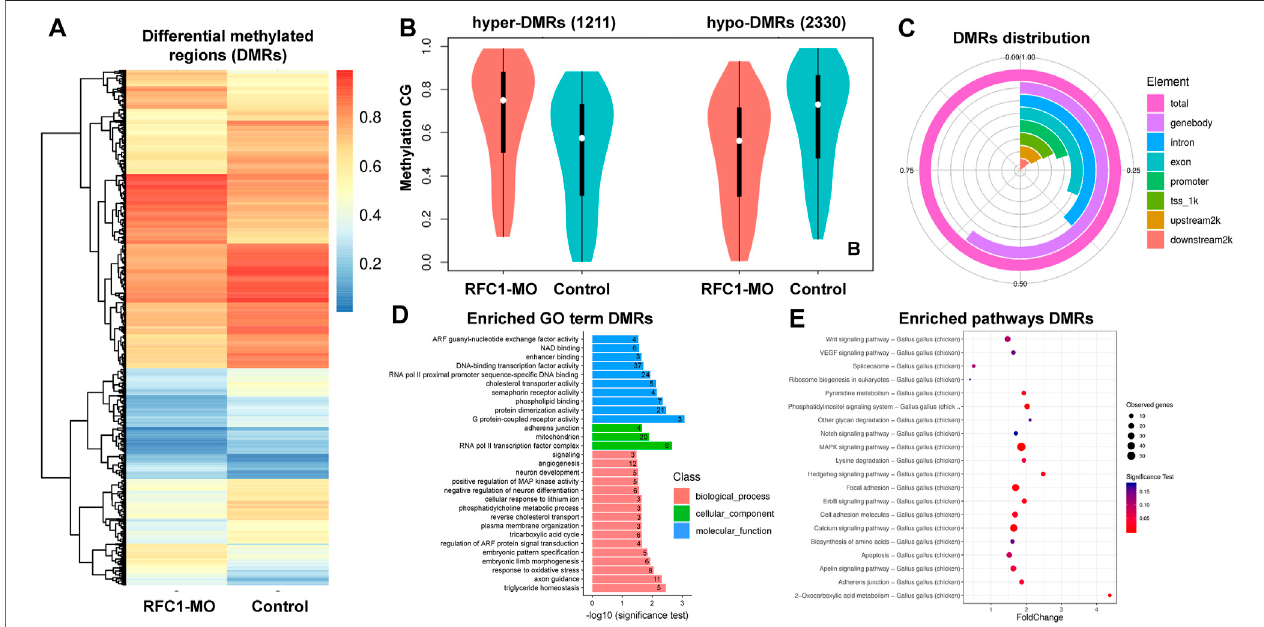
FIGURE4| Identi fi cationofdifferentiallymethylatedregions(DMRs)onfolatecarrierde fi cientembryos. (A) HeatmapofDMRsshowingsigni fi cantdifferencesinCG methylation between the folate de fi cient (RFC1-MO) and control (Control) embryos. Each raw in the heat map correspond to data point from single region, whereas column correspond to treatments. The branching dendogram correspond to the relationship among data point as determined by clustering using 3,541 DMRs. Hyper- and hypomethylated regions are shown on a continuum from red to blue, respectively. See also Supplementary Table S1 . (B) Violin boxplot comparing hyper- (1,121) and hypo- (2,330) DMRs between the control and RFC1-MO embryos. (C) Genomic distribution of the DMRs. From the 3,541 DMRs, 2,145 were at the gene body, 590 upstream2k, 493 downstream2k, 1,348 in introns, and 712 in promoters. (D) Bar plot showing enriched Gene Ontology (GO) terms from genes associated with the DMRs. Numbers inside each bar indicates the total of GO-related genes. The horizontal axis indicates the signi fi cance of the test (adjP). See also Supplementary TableS2 . (E) Scatterplot showing enriched KEGG pathways from genesassociated withthe DMRs. The vertical axis representsthepathway and the horizontal axis represent the fold change. The size of the dots indicates the number of affected genes in the pathway and the color corresponds to a different p -value range.Seealso SupplementaryTableS3 .DMRsanalysiswasperformedbyusingmetilenesoftwareusingadoublestatisticaltest(MWU-testand2DKS-test)followed by multiple test correction (adj. p -value). GO enrichment and KEGG enrichment signi fi cance was evaluated by raw P (Hypergeometric test p -value) followed by correct p -value